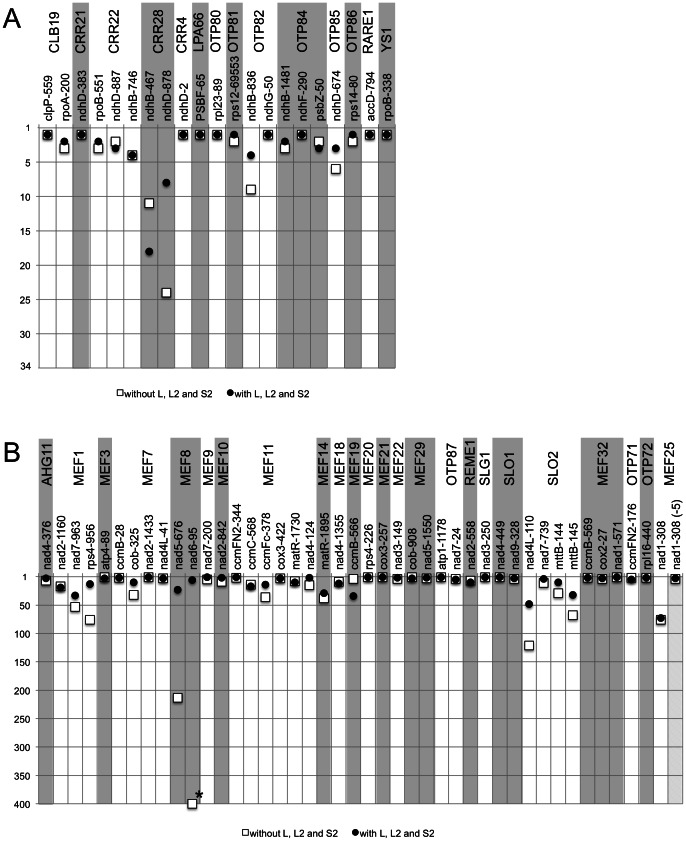
Inclusion of L, L2 and S2 repeats generally improves the prediction accuracy of RNA editing targets.Although the bona fide target sites are listed in the top ranks even without including the L, L2 and S2 repeats, their consideration mostly improves the prediction accuracy if only slightly. This suggests that these repeats also connect to target RNA sequences. Shown here are only the data for Arabidopsis. For Physcomitrella mitochondria, prediction ranks target sites always at the top, but then there are only very few editing sites in this moss (Figure S3). (A) Prediction of the target sites for the known chloroplast editing factors finds the identified targets within the top ranks out of the 34 RNA editing sites in chloroplasts of Arabidopsis. Prediction from only the P and S repeats (□) is usually sufficient, but inclusion of the L, L2 and S2 elements (•) often improves the ranking. (B) Analogous improvements of the predictions are seen within the 430 editing sites considered for mitochondrial PPR proteins. In a few instances the predicted PPR-RNA interaction drops in rank when the L, L2 and S2 elements are included (e.g. the targets of MEF18 and MEF19; further details are given in Figure S3). The nad6-95 target site of MEF8 (asterisk) cannot be ranked since the p-value is >1 in the FIMO program evaluation.